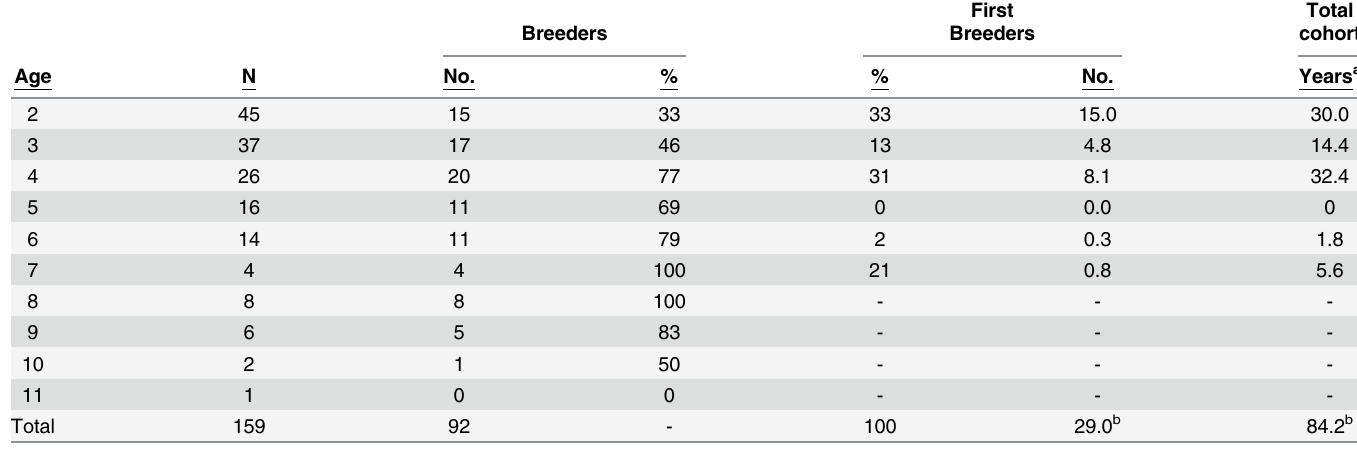
Table 7. Deriving mean age of primiparity from wolf breeder data from throughout Minnesota wolf range (Table